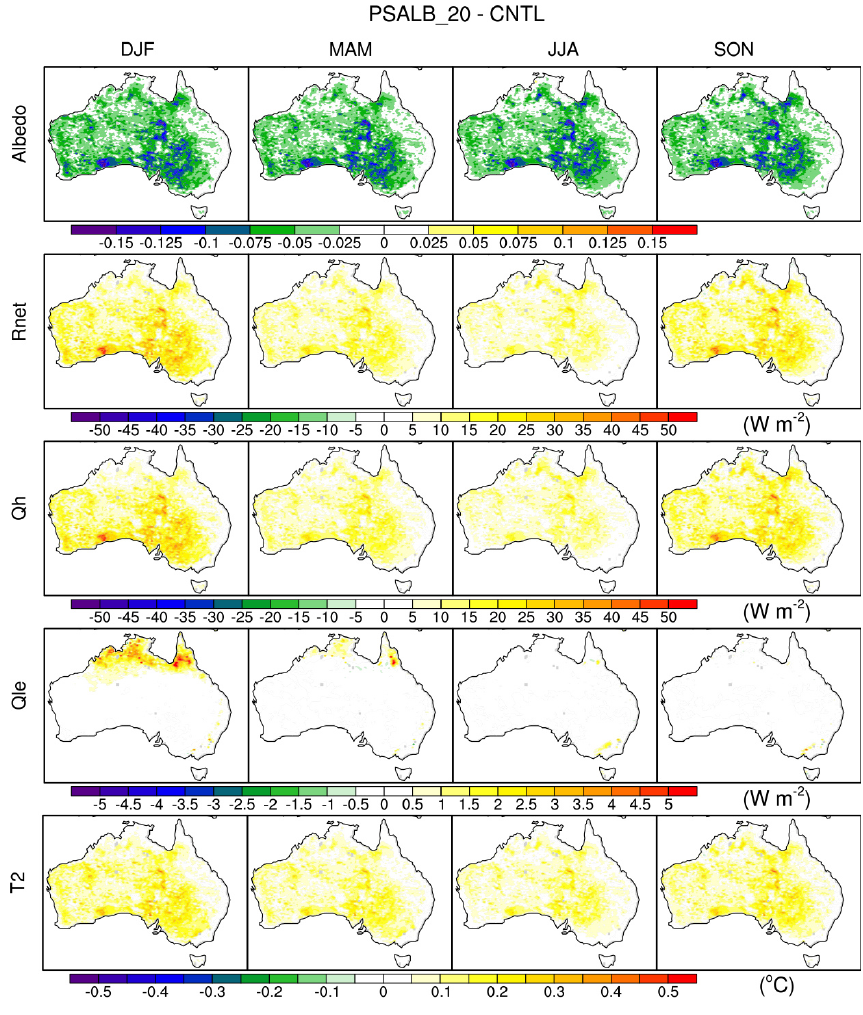
Figure 13. Same as in Fig. 10 but for the PSALB_20